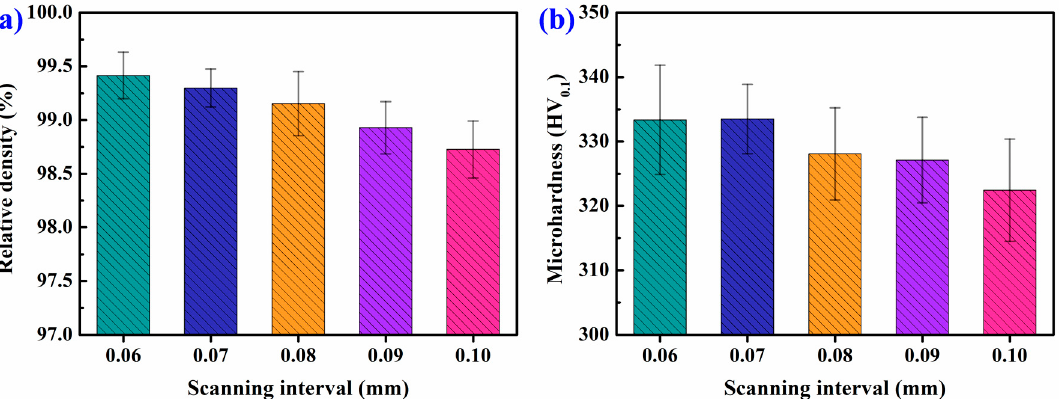
Figure 4. The density ( a ) and microhardness ( b ) of as-LPBFed TA15 titanium alloy under various scanning intervals.